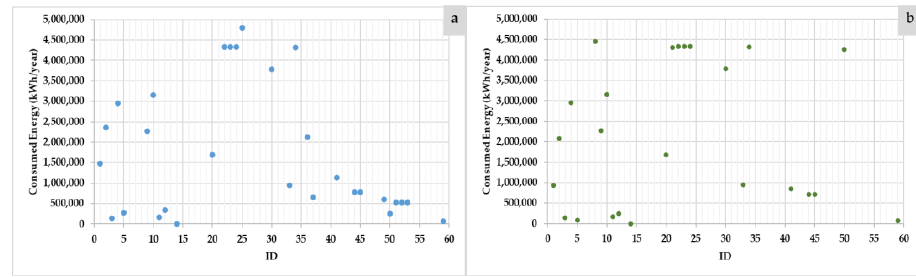
Figure 6. Energy consumed related to water usage for OS ( a ) and MS ( b ). Depending on the reduction in energy consumption and the average flow of water through a network, the emission of greenhouse gases related to the use of water is also modified. This is shown in Figure 7, in which there are different supplies in its original operating station that emit more than 500,000 t CO 2 /year and an analyzed peak value of